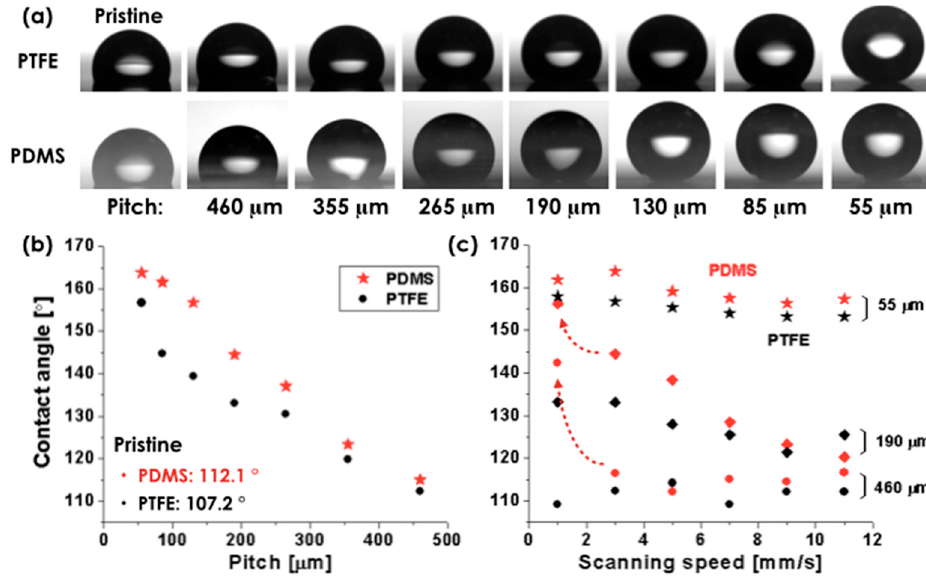
Figure 4. ( a ) Microscopic pictures of water droplet on surface modified PTFE sample and PDMS replica at the laser fluence of 35.0 J/cm 2 and the scanning speed of 3 mm/s; ( b ) measured contact angle of the droplets in ( a ); and ( c ) contact angle of droplets on surface modified PTFE sample at varied scanning speeds and PDMS replica.